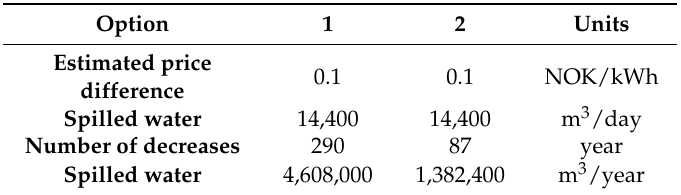
Table 5. Cost assumptions.